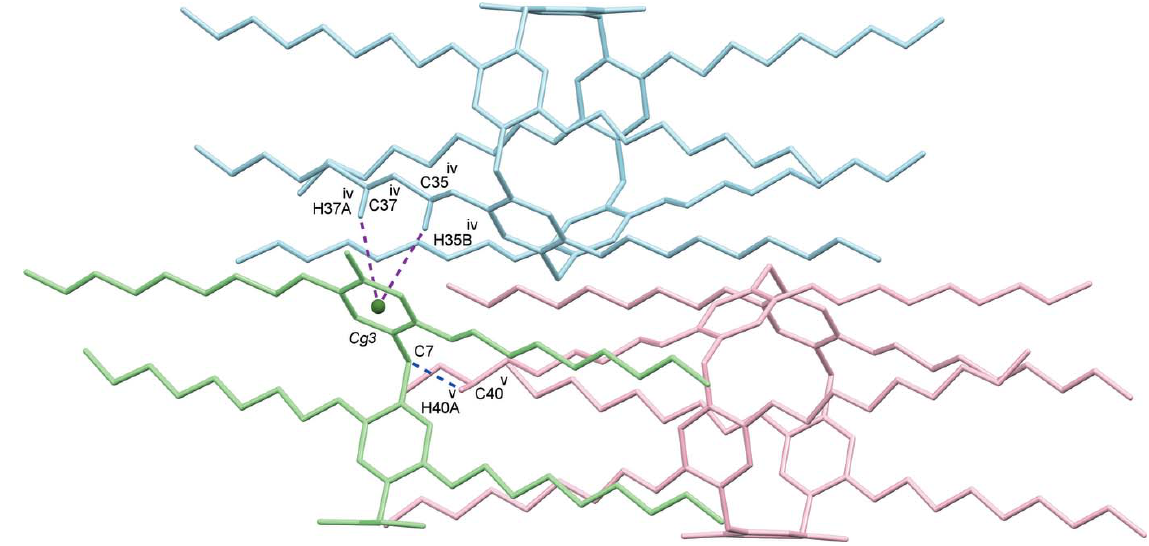
Figure 3 Adjacent pillararene fragments are connected by weak C—H (cid:2)(cid:2)(cid:2) C and C—H (cid:2)(cid:2)(cid:2) (cid:2) interactions in the crystal. Those interactions that are involved in supramolecular pillararene chain formation are omitted for clarity. Cg 3 is the centroid of the C8–C13 ring. [Symmetry codes: (iv) (cid:3) x + 1, (cid:3) y + 2, (cid:3) z + 1; (v) (cid:3) x + 1, y , (cid:3) z + 3 2